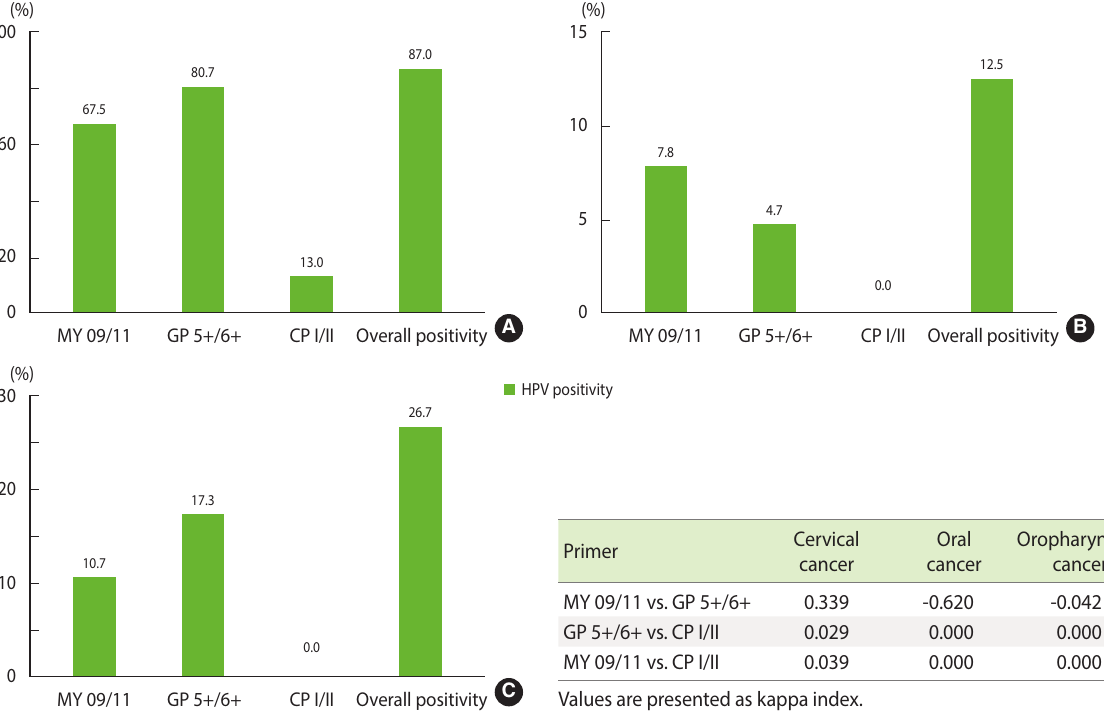
Figure 2. Human papillomavirus (HPV) positivity by degenerative primer sets in (A) cervical cancer, (B) oral cancer, and (C) oropharyngeal